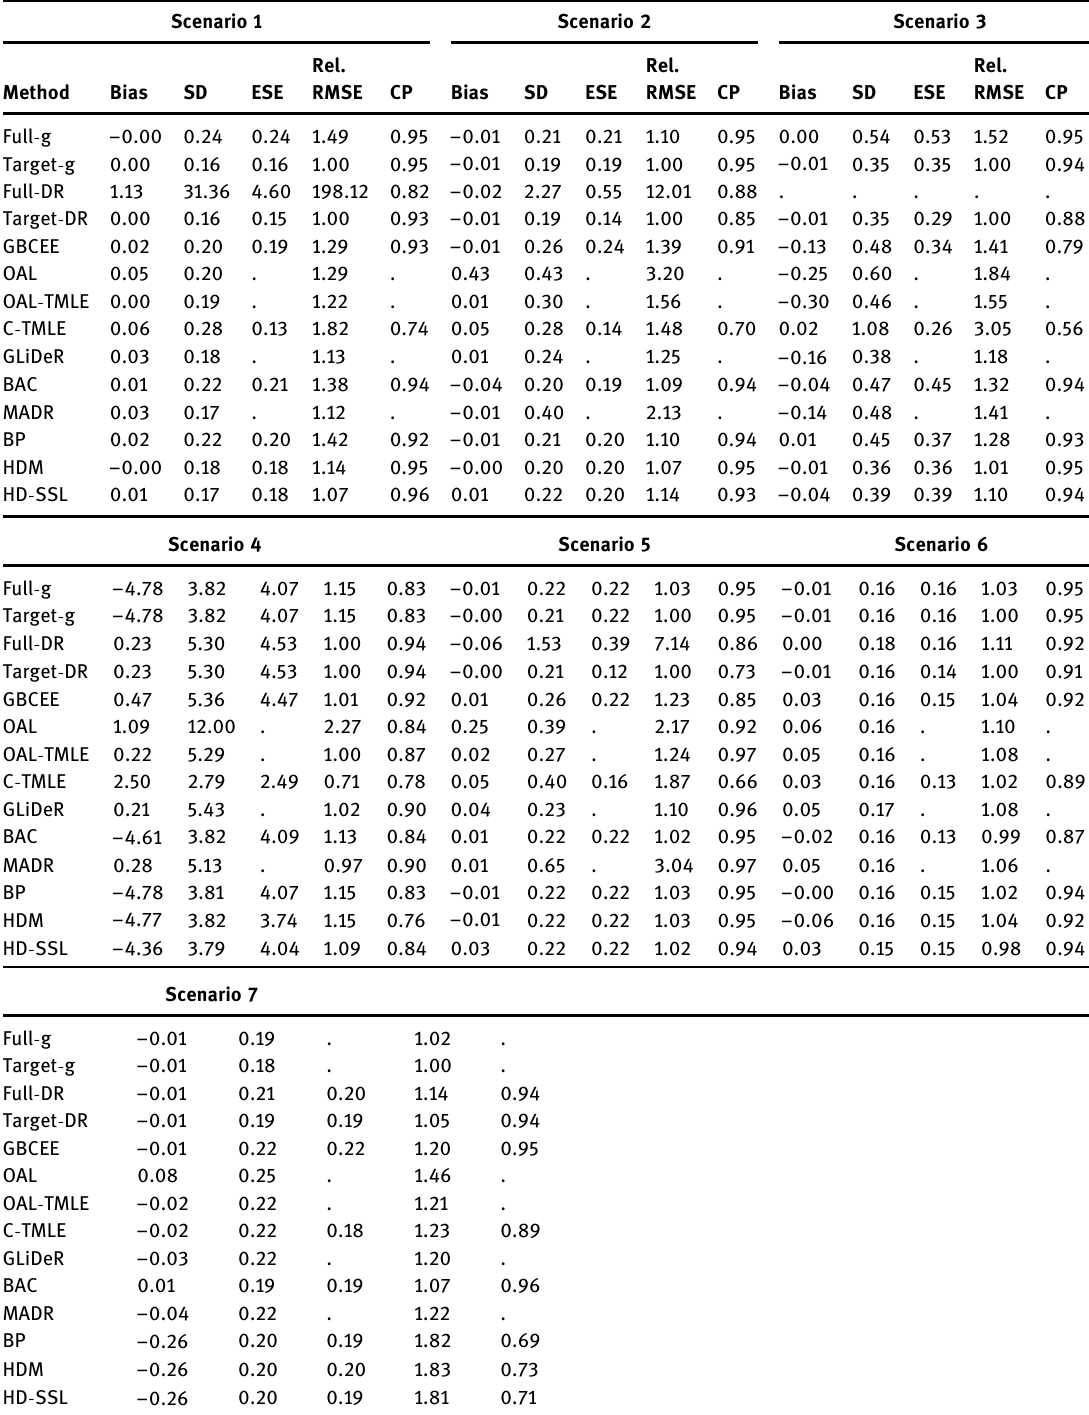
Table A4: Results of simulation Scenarios 1 – 7, with n 200